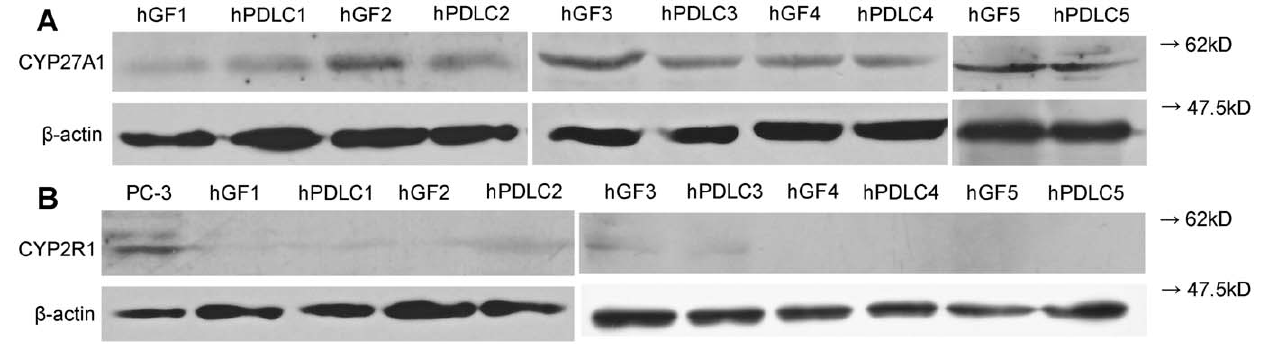
Figure 2. Protein expression of CYP27A1 and CYP2R1 in hGF and hPDLC. Protein expression of CYP27A1 was detected by Western blot in hGF and hPDLC from all five donors (donors are numbered 1–5). Protein expression of CYP2R1 was detected by Western blot in PC-3 cells, which were used as a positive control, but was not detected in hGF and hPDLC. b -actin was used as an internal control.